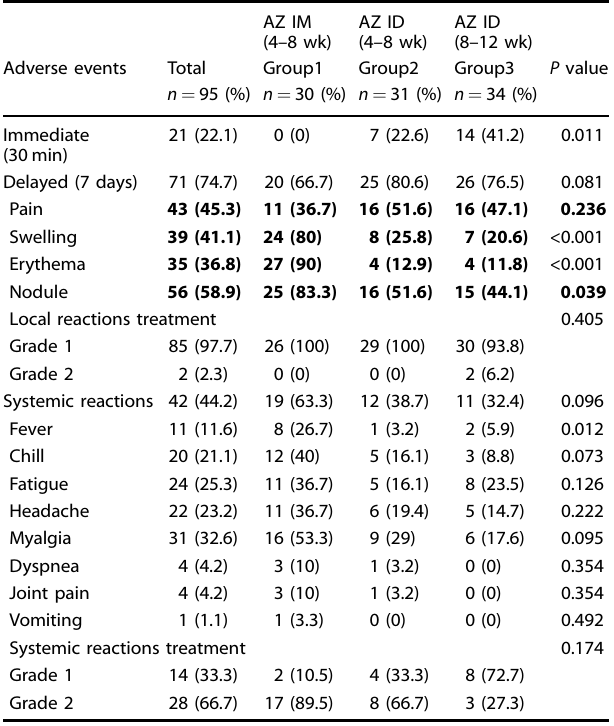
P value refers comparisons between Group1 and Group2 which were determined using Chi ’ s square